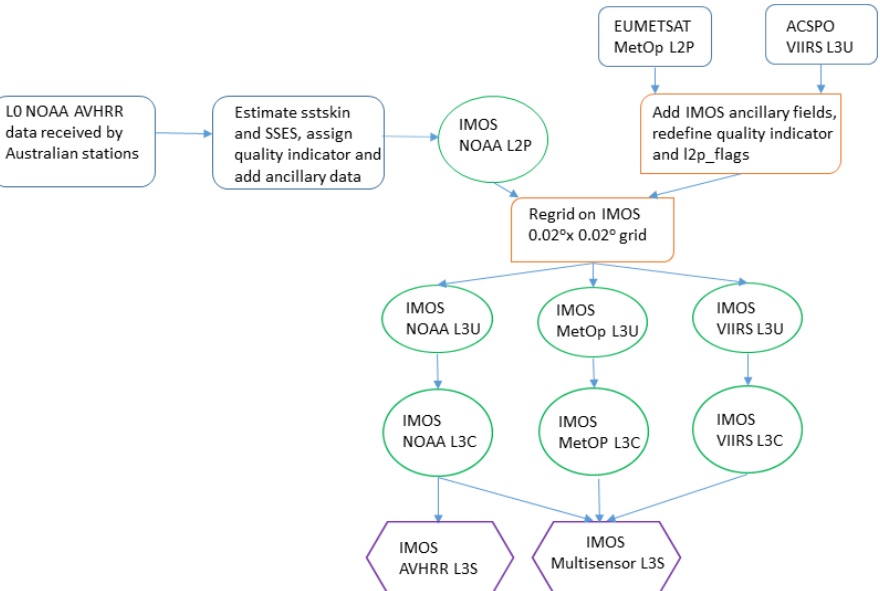
Figure 1. Overview of processing methods to composite data from different satellite sensors to construct Multi-sensor L3S SST